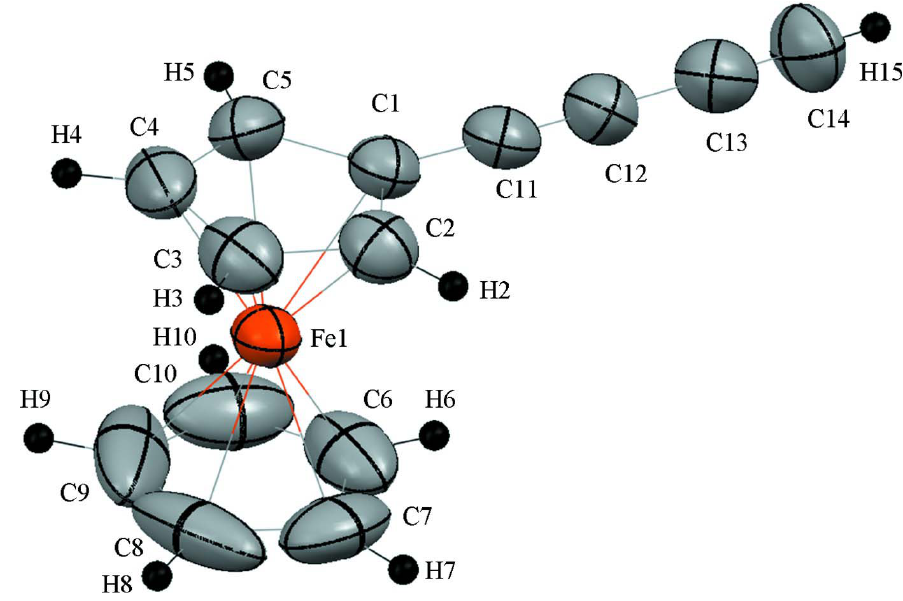
The title compound with displacement ellipsoids drawn at the 50% probability level. H atoms are shown as spheres of arbitary